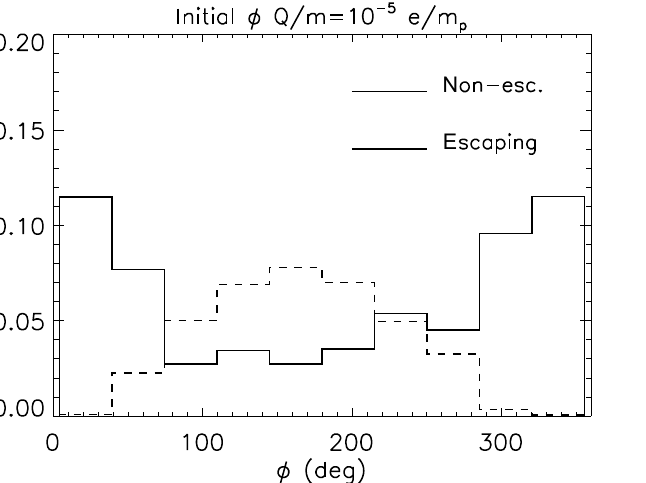
Figure 6. As Fig. 4 but for the distribution in initial heliographic longitude.